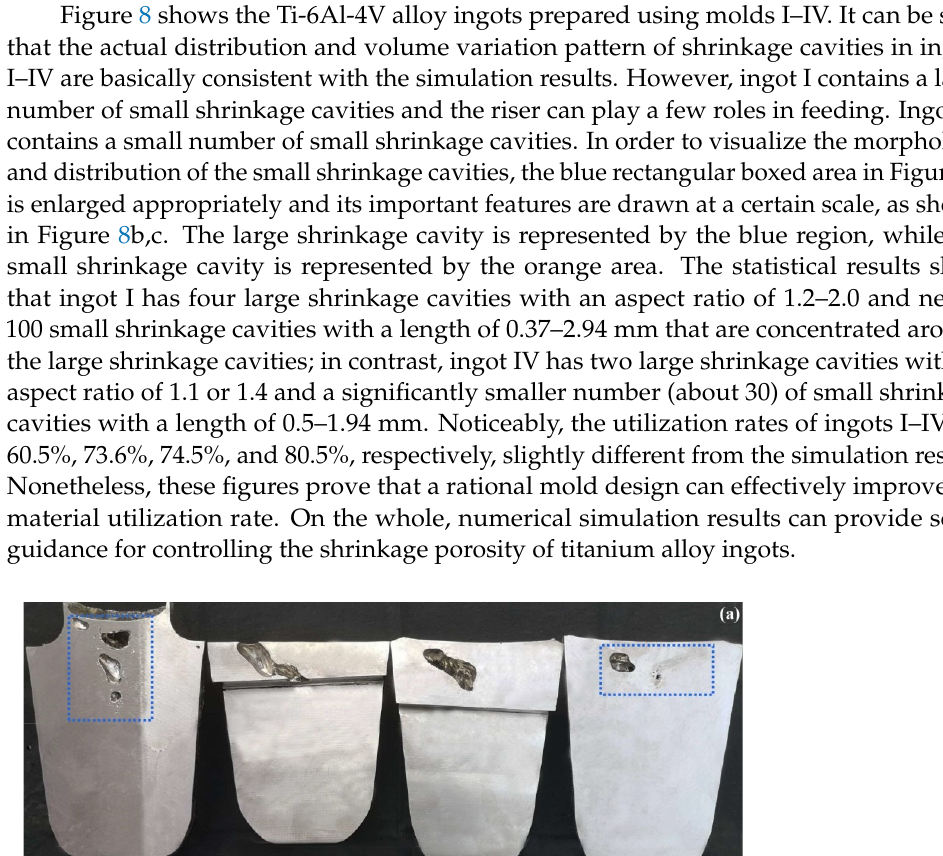
Figure 7. Distribution of shrinkage porosity for Ti ‐ 6Al ‐ 4V alloy in mold II–IV: ( a ) II; ( b ) III; ( c ) IV.